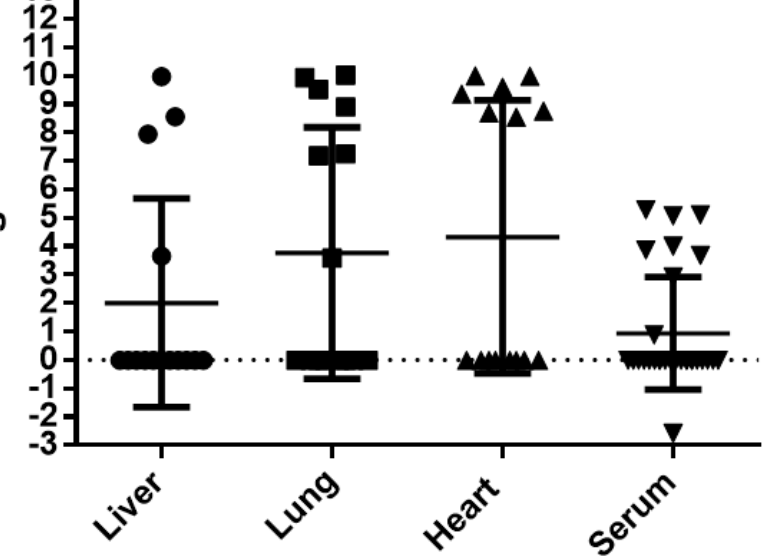
Figure 10. Individual titers of DENV-4 RNA detected in liver, lung, heart and serum of infected BALB/c mice, expressed in logarithmic values.